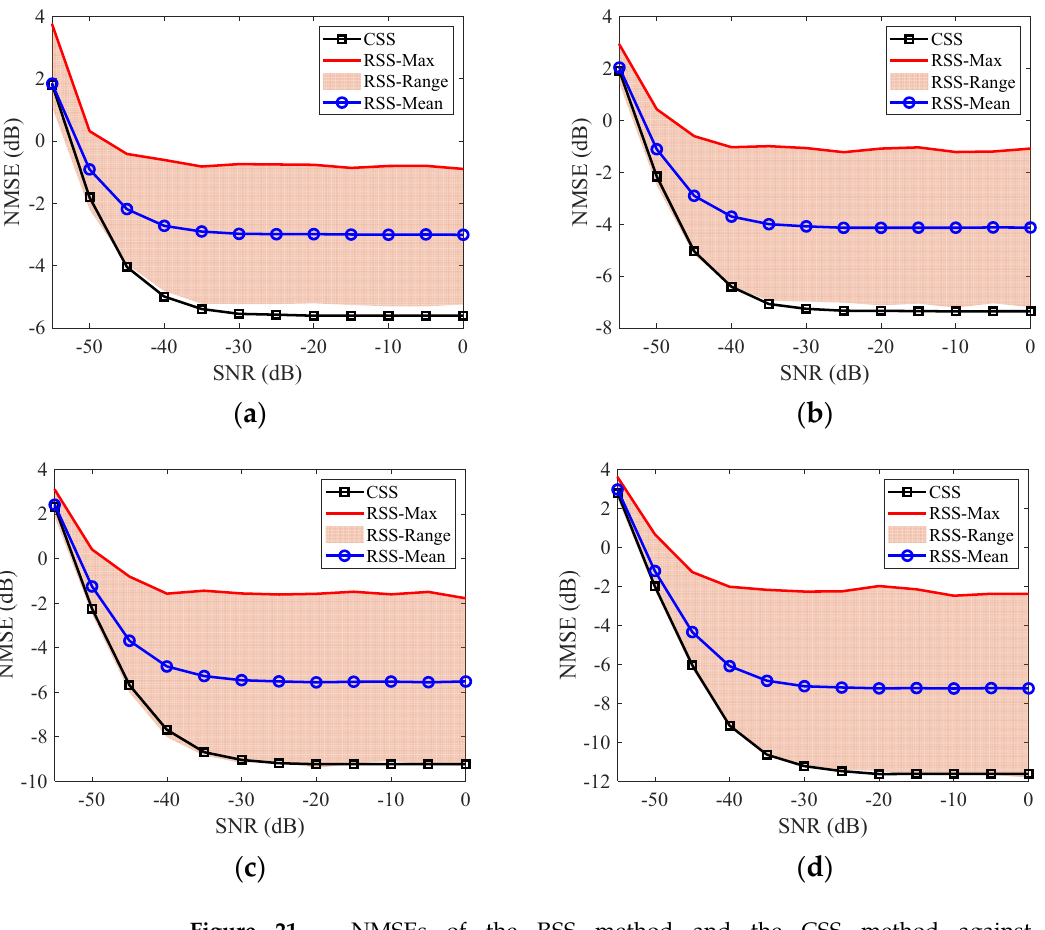
Figure 21. NMSEs of the RSS method and the CSS method against SNRs with ( a ) M S = N S = Q S /2 = 20, ( b ) M S = N S = Q S /2 = 22, ( c ) M S = N S = Q S /2 = 24, and ( d ) M S = N S = Q S /2 = 26.